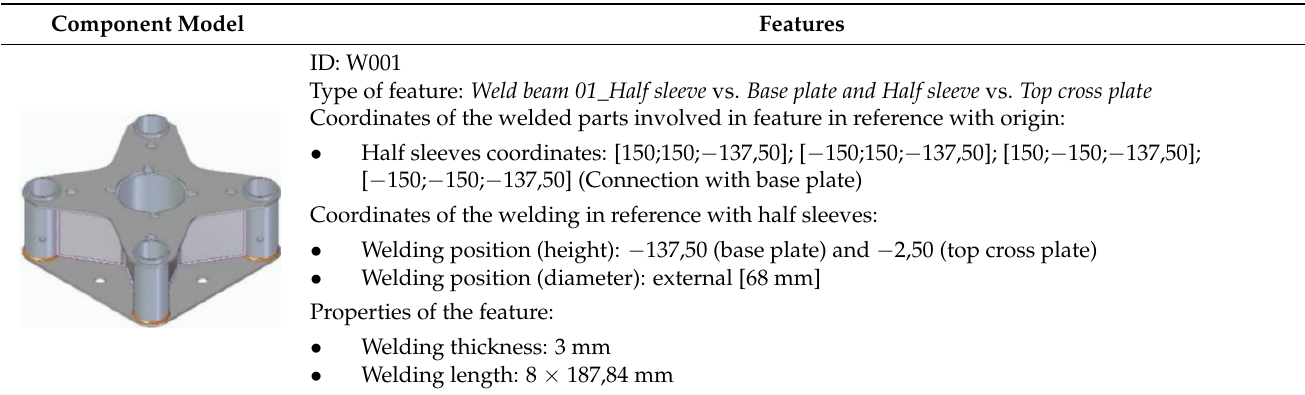
Table 4. Welding features (highlighted in orange) extracted by the 3D CAD model of the jack adapter. Component